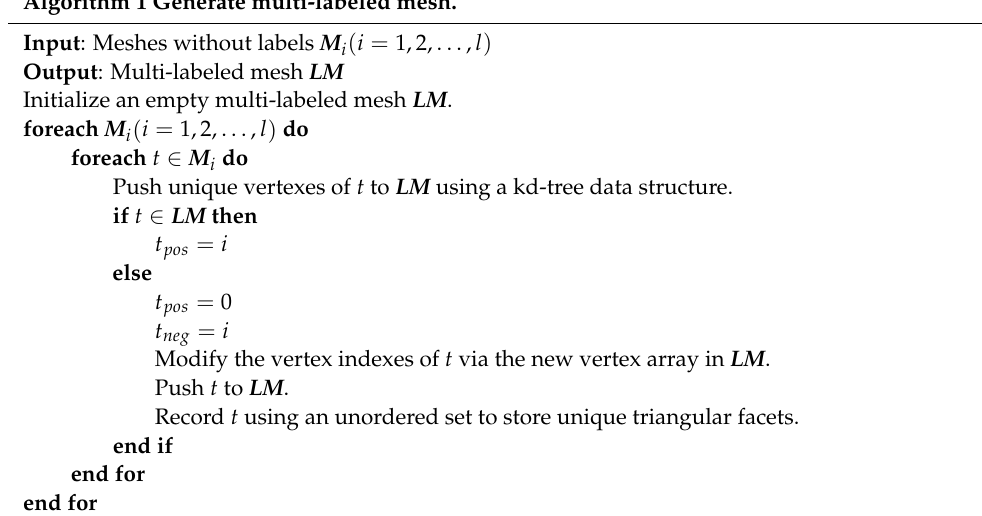
Algorithm 1 Generate multi-labeled